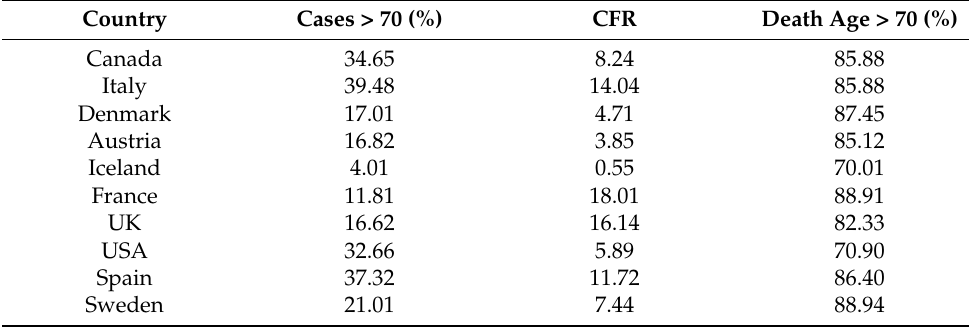
Table 5. Distribution of cases and CFR of COVID-19 patients across various countries.